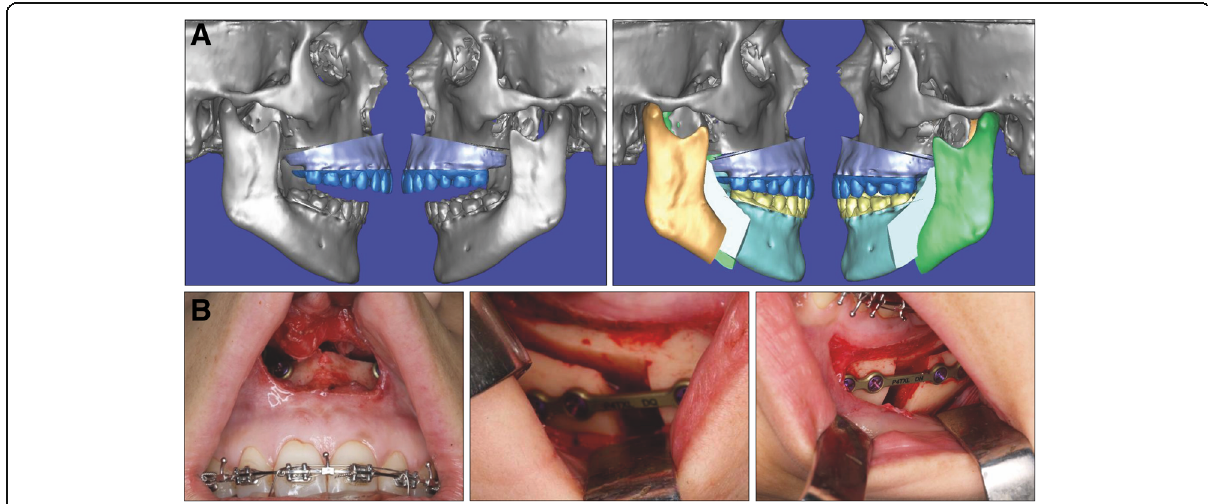
Fig. 5 a Surgical treatment plan generated by SimPlant software. b Trans-surgical photographs showing LeFort I osteotomy and bilateral sagittal split osteotomy for mandibular